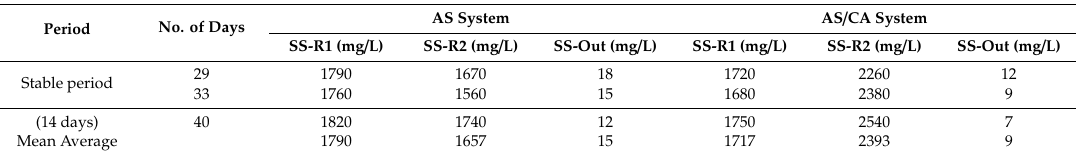
Table 7. Quantity of sludge and SS in synthetic domestic sewage treated using AS system and AS/CA System .